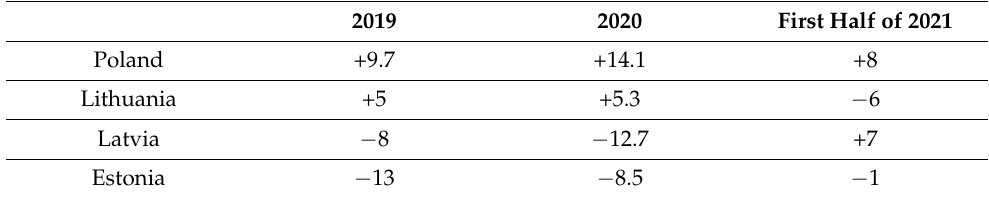
Table 1. Average changes in electricity prices between 2019 and 2021 in Poland and the Baltic States, relative to national currencies [40].